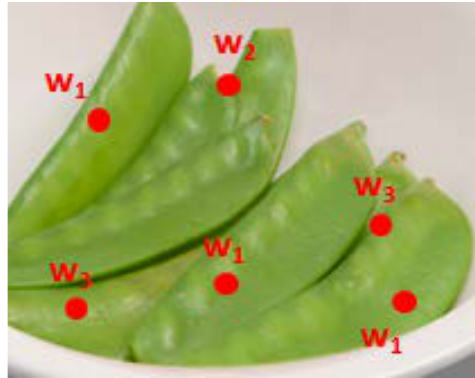
Figure 1. An image of snowpeas showing interest points shown as red points and the corresponding best matching codewords labelled w 1 , w 2 , w 3 .